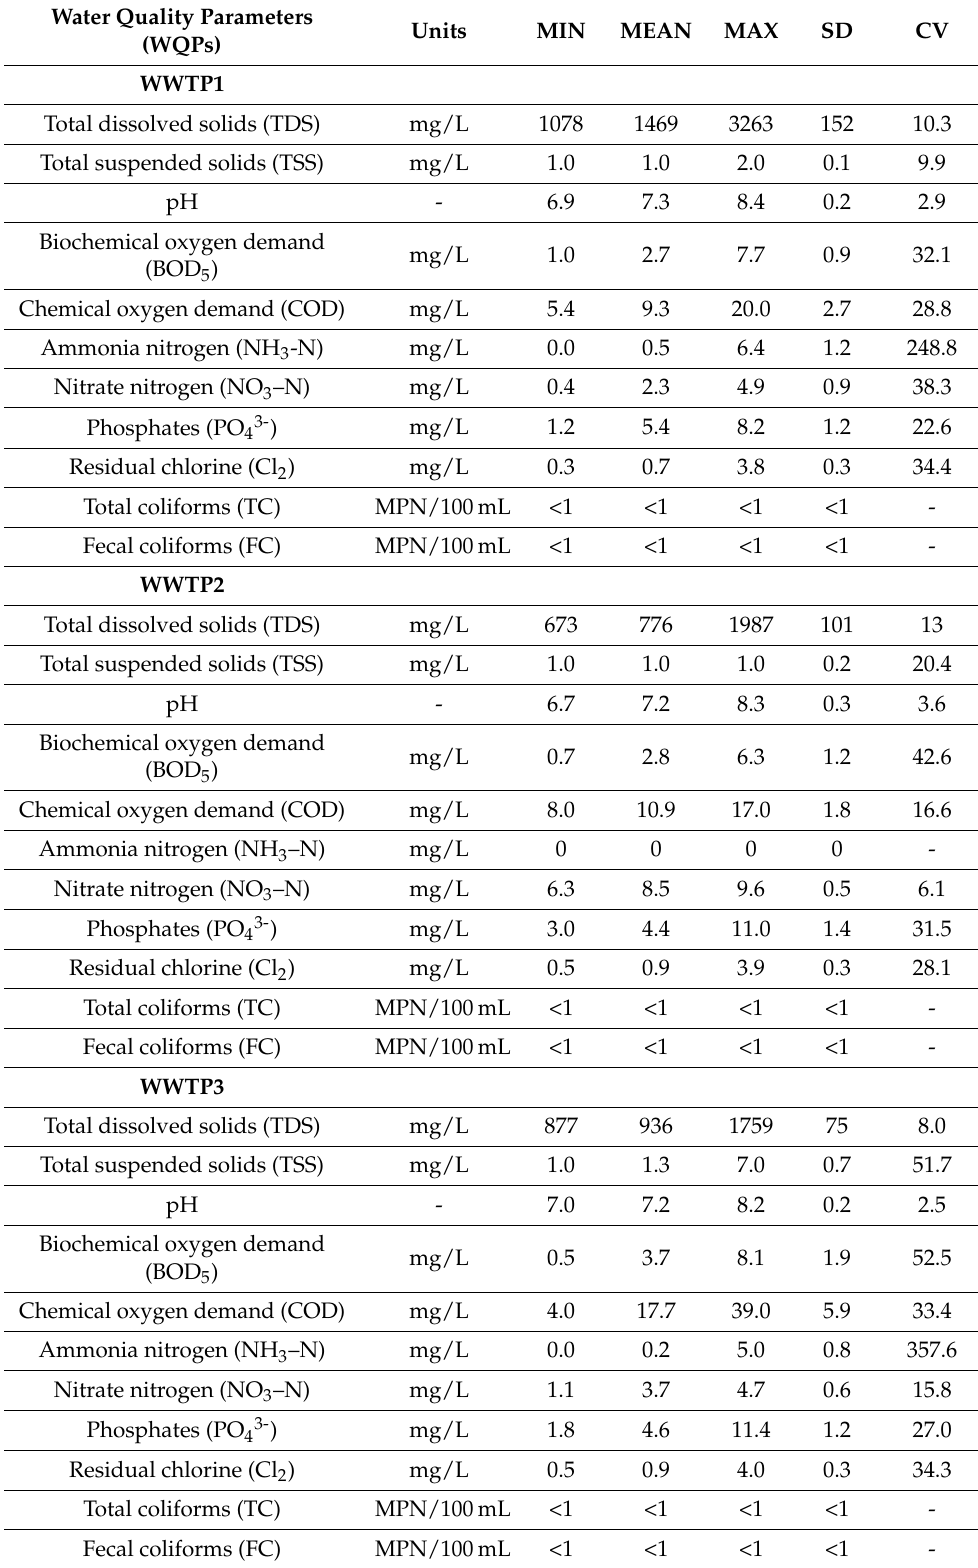
Table 6. Summary of water quality monitoring data for the four WWT